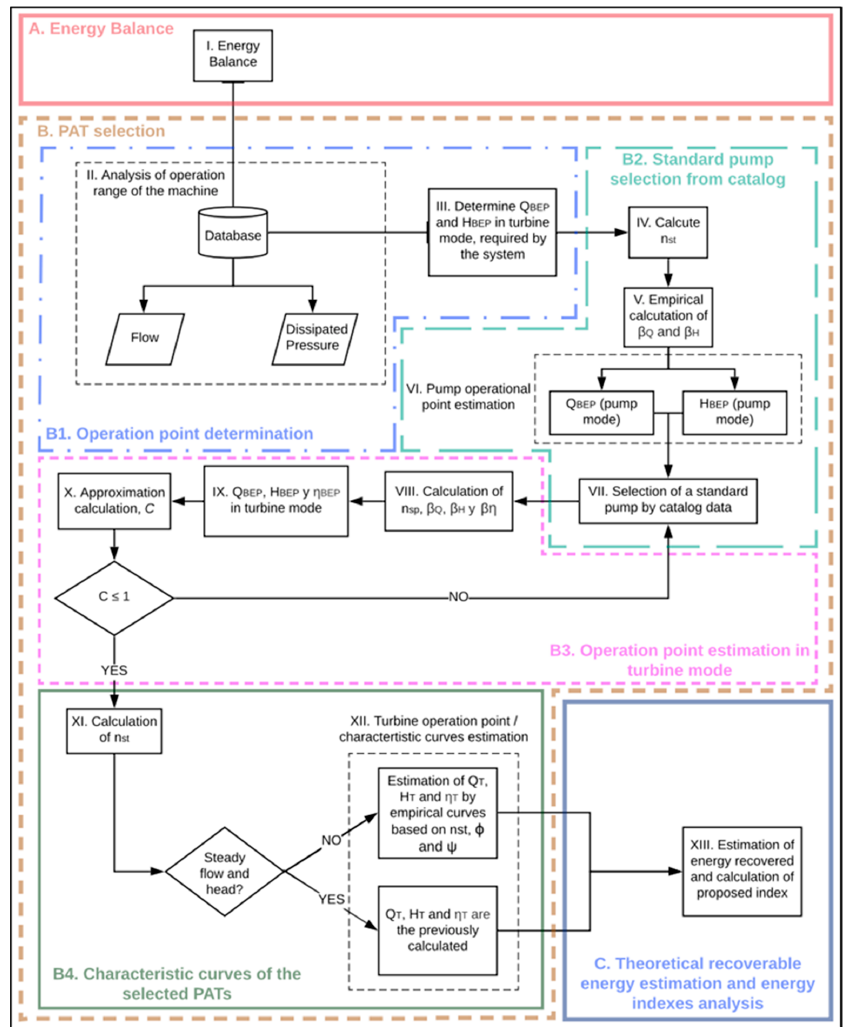
Figure 1. Proposed methodology for the selection of pumps used as turbines ( PATs ).